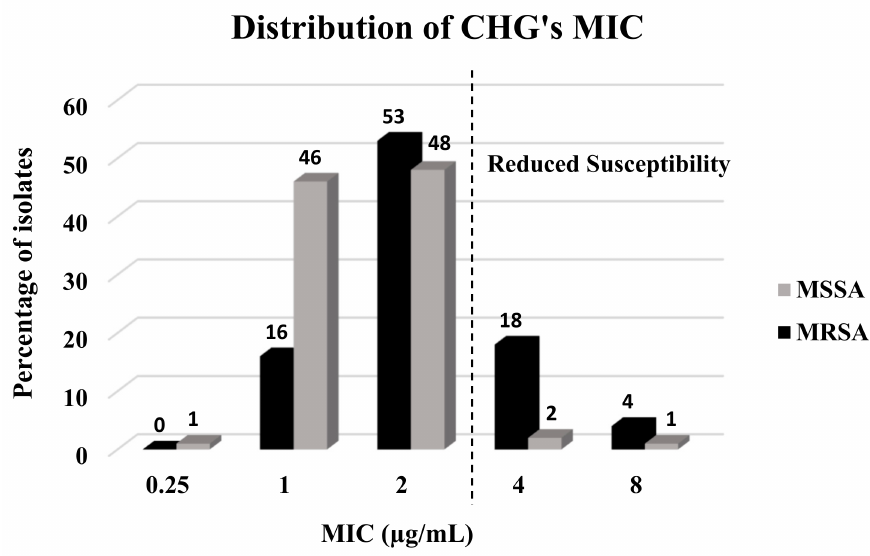
Figure 2. Distribution of CHG’s MICs (mg/L) among clinical isolates. 2.3. The Associations between Phenotypic and Genotypic Tolerance to CHG An association was found between the genotypic and phenotypic tolerance to CHG ( p < 0.001) (Table 3). When only MSSA isolates were assessed, no association between the genotype and the phenotype was found ( p = 0.717). In contrast, in MRSA strains, the phenotype and the genotype of CHG susceptibility were linked ( p = 0.004) (Table 4). Table 3. Clinical and epidemiological characteristics of CHG-tolerant vs. CHG-susceptible isolates. Reduced Susceptibility to Characteristic